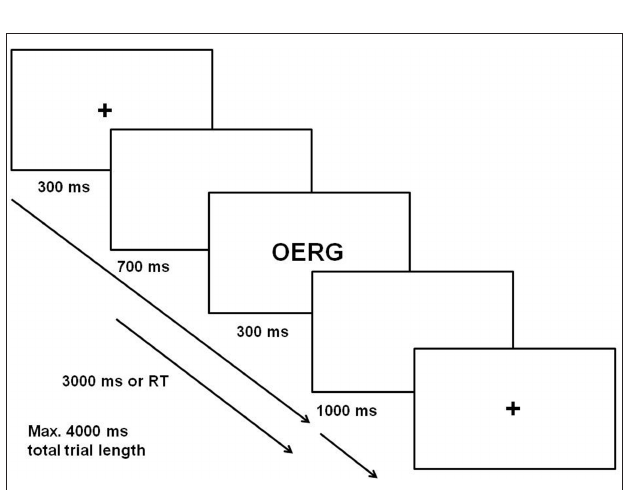
Figure 2 | Timing and sequence of events in experiment